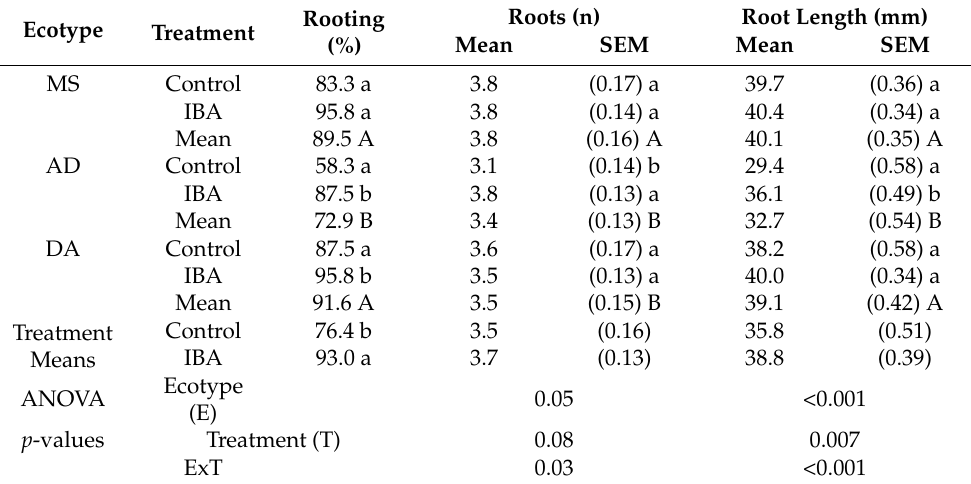
Table 2. Rooting percentage, mean number of formed roots and mean root length in cultured shoots of three S. acmophylla ecotypes subjected to either IBA 5 µ M or control treatment (AC 0.2 mg L − 1 ). MS—Mea Shearim; AD—Adom;